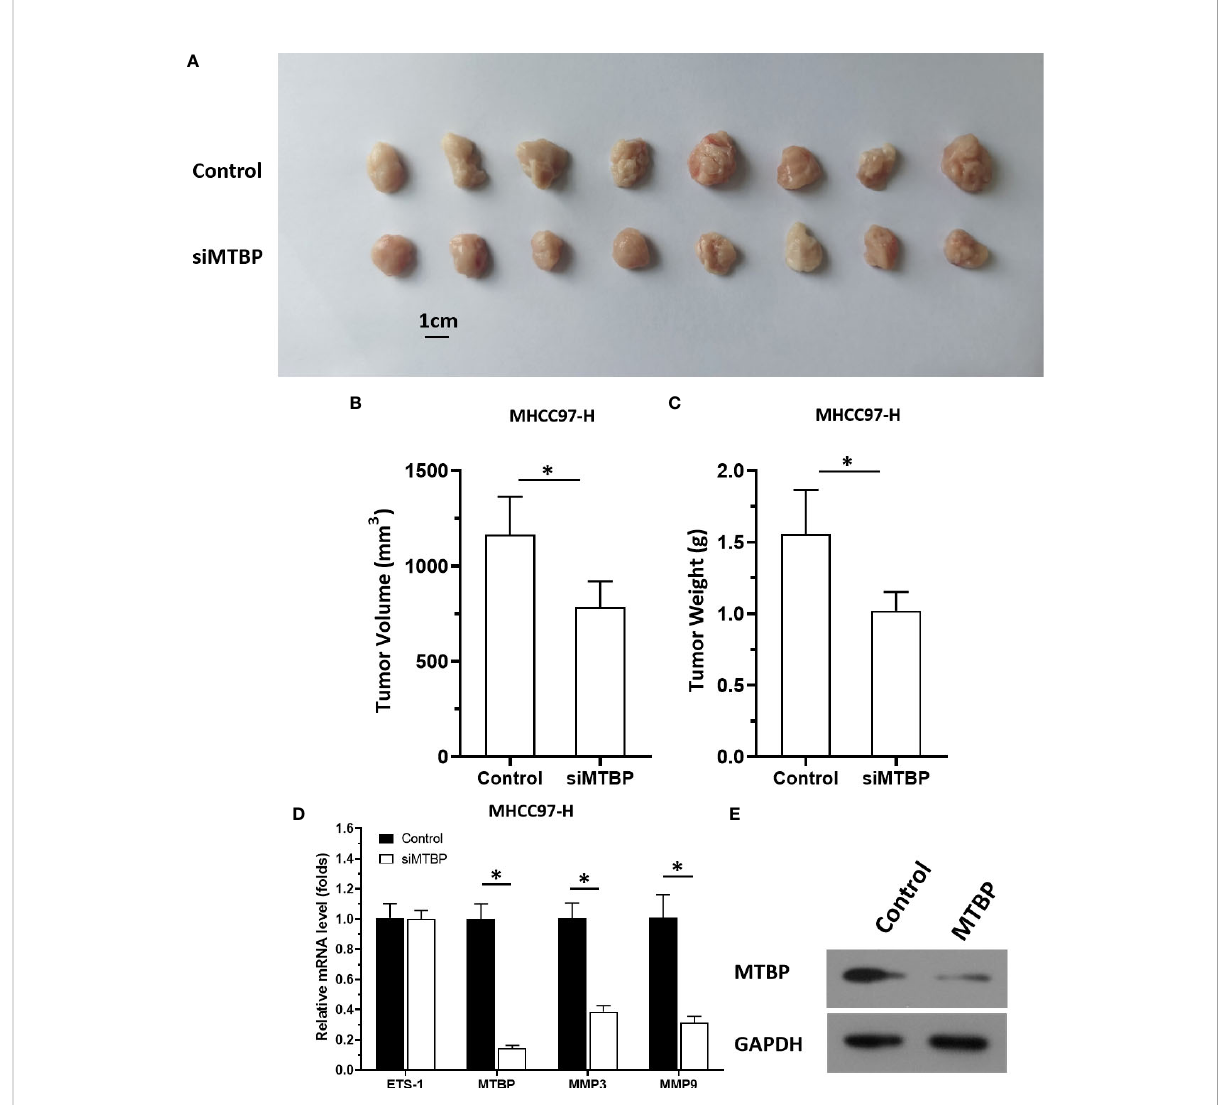
FIGURE 10 Knockdown of MTBP via its siRNA causes a decrease in in vivo growth and ETS-1 activation in HCC tumor tissues. The MTBP was knockdown in MHCC97-H cells via its siRNA via stable transfection and cells were injected into nude mice to form subcutaneous tumor tissues. (A) the tumor tissues formed by MHCC97-H cells knockdown MTBP via MTBP siRNA. (B, C) the volumes or weights of tumor tissues formed by MHCC97-L cells ’ knockdown MTBP via MTBP siRNA. (D) Expression levels of ETS-1, MTBP, mmp3, ormmp9 in the tumor tissues. (E) the images of western blot was shown to indicate the stable transfection of siMTBP. *P <